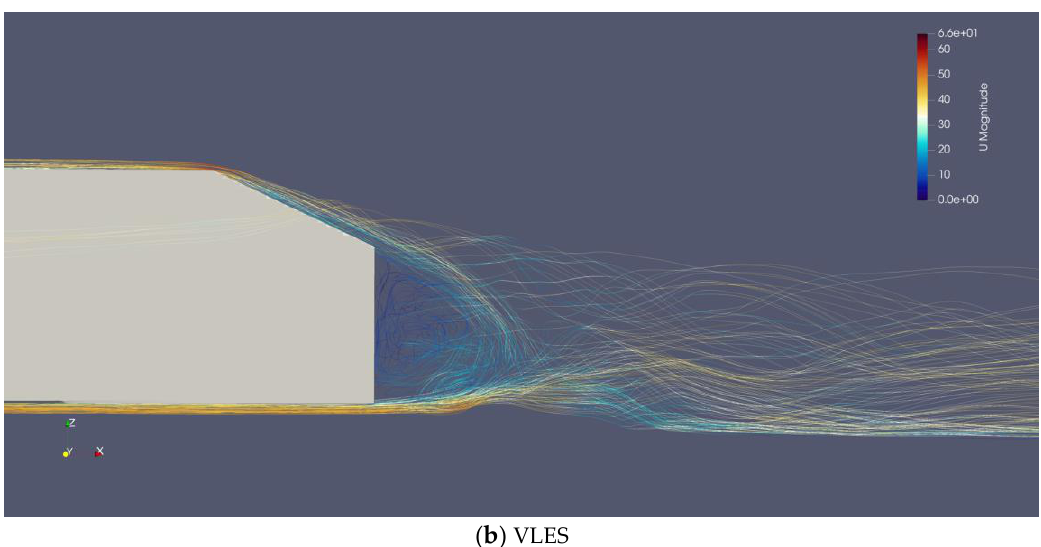
Figure 14. The streamlines at the back of the Ahmed Body by ( a ) URANS k - ω SST and ( b ) VLES. The validation of VLES simulations by comparison with the experimental drag coeffi- cient was also performed. Here the drag coefficients of different models, including RANS ( k - ω SST), URANS, VLES, DES and LES, were compared with the experimental measure- ment (0.298) in Table 3. As with the observations by Igali et al. [5] and Sadykov et al. [8], the performance of RANS is comparable to those of DES and LES, with DES being the worst inaccuracy, and URANS better than the three. Finally, the VLES is the best in accuracy among the five models. Table 3. Drag coefficients by RANS, URANS, VLES, DES and LES and their comparison with experimental